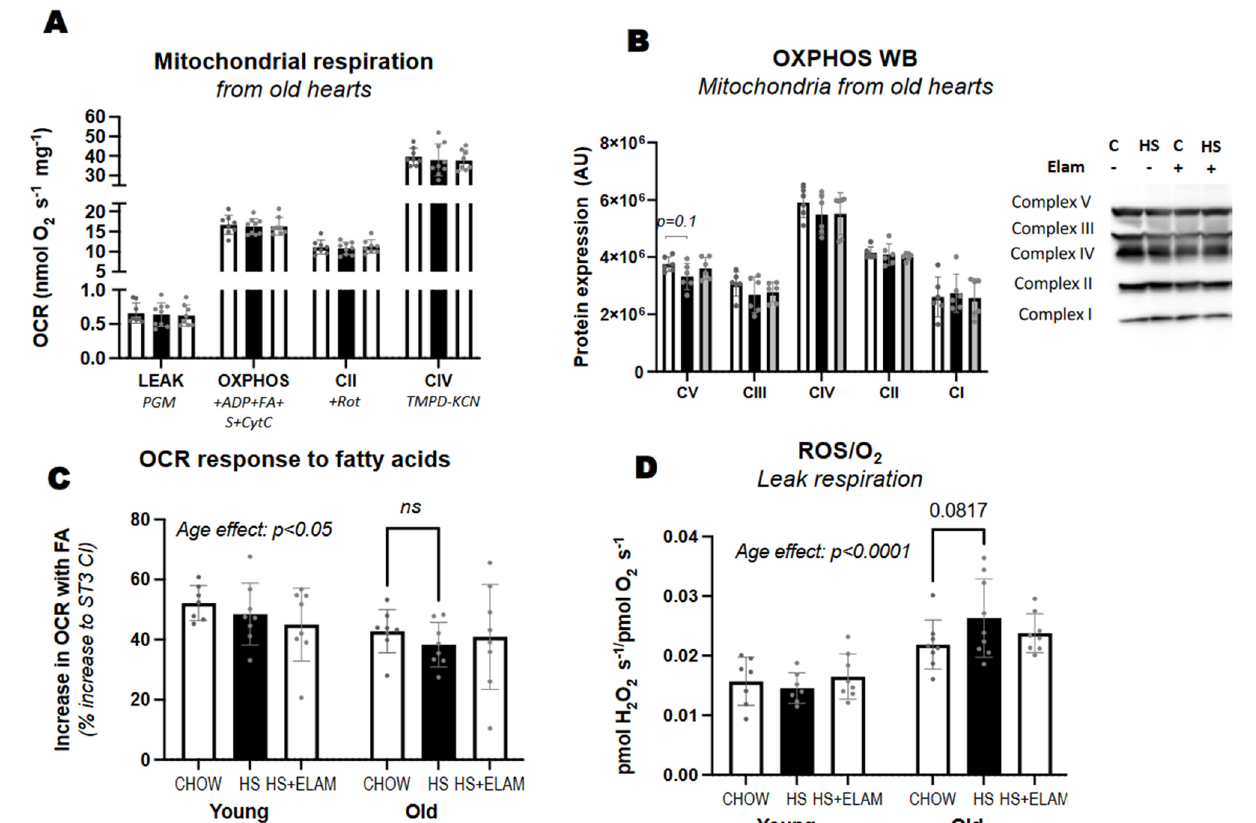
Figure 4. Mitochondrial respiration and hydrogen peroxide production. Mitochondrial respiration using Oroboros O2K ( A , C ) and protein content of electron transport chain complexes assessed by immuno blot ( B ) were measured in isolated mitochondria from freshly isolated hearts. The rise in respiration with the addition of fatty acid (FA) octanoylcarnitine in the presence of complex I substrates and ADP was quantified for each age and treatment group ( C ). The ratio of reactive oxygen species (ROS) to oxygen being consumed by isolated mitochondria ( D ). Significant differences between old and young are indicated by age effect; differences between old-chow and old-HS are indicated with smaller brackets containing p –values between 0.05–0.1 or asterisks if significant, p < 0.05, or NS if p –value is above 0.1. Data expressed as mean ±